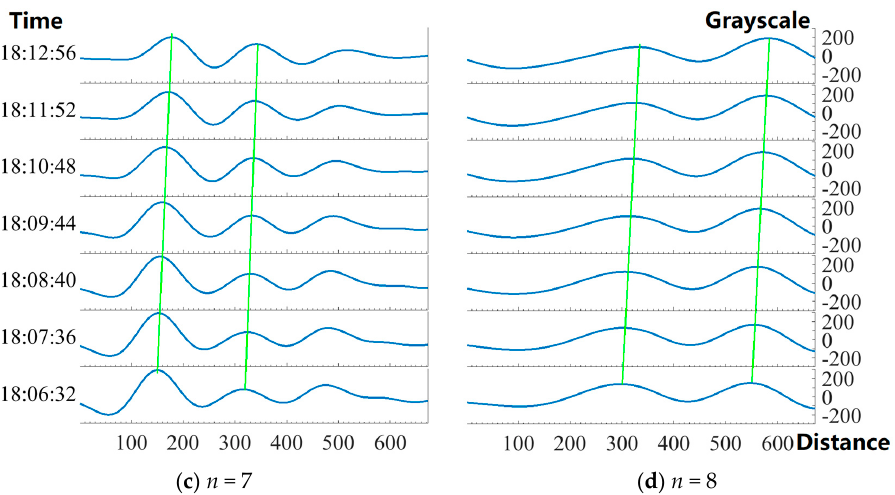
Figure 7. Waveforms along the measuring line. Subfigures ( a ), ( b ), ( c ) and ( d ) represent the evolutions of wave forms in 5–8th layers, individually. The horizontal axes indicate the distance (in km) from the starting point of the green arrow. The left axes are the time (UTC) and the right axes are the grayscale. The green lines mark out the movement of wave peaks along the time.